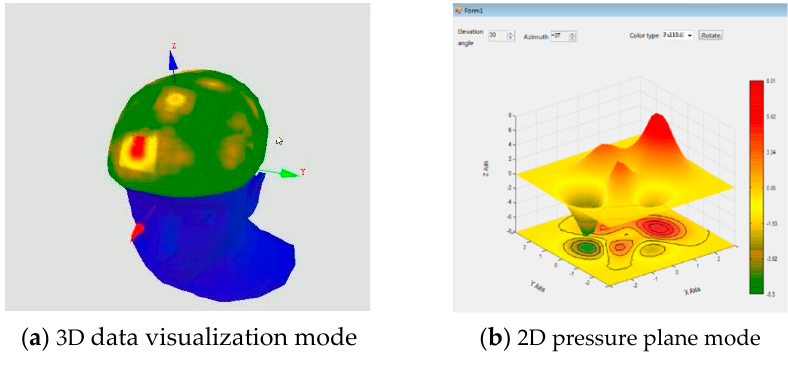
Figure 8. Image generation.